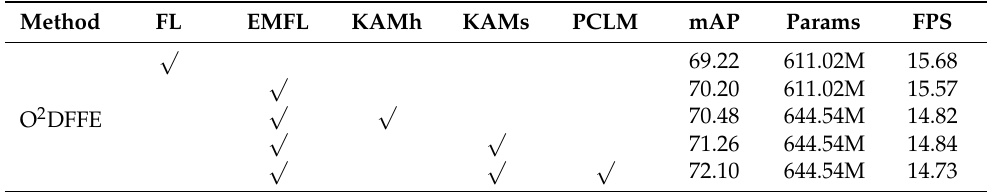
Table 4. Results of ablation studies on DOTA datasets. KAMh means KAM with hard label and KAMs means KAM with soft label.